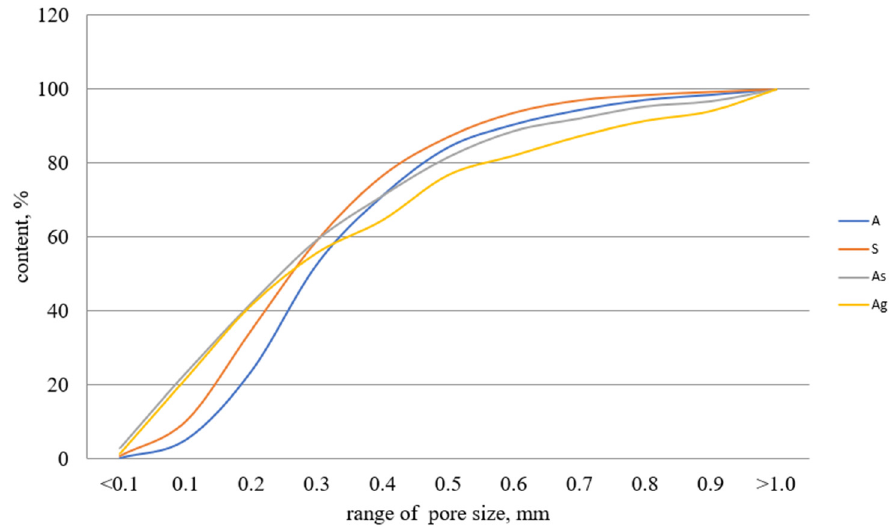
Figure 4. Comparison of pore size distribution in geopolymer samples.